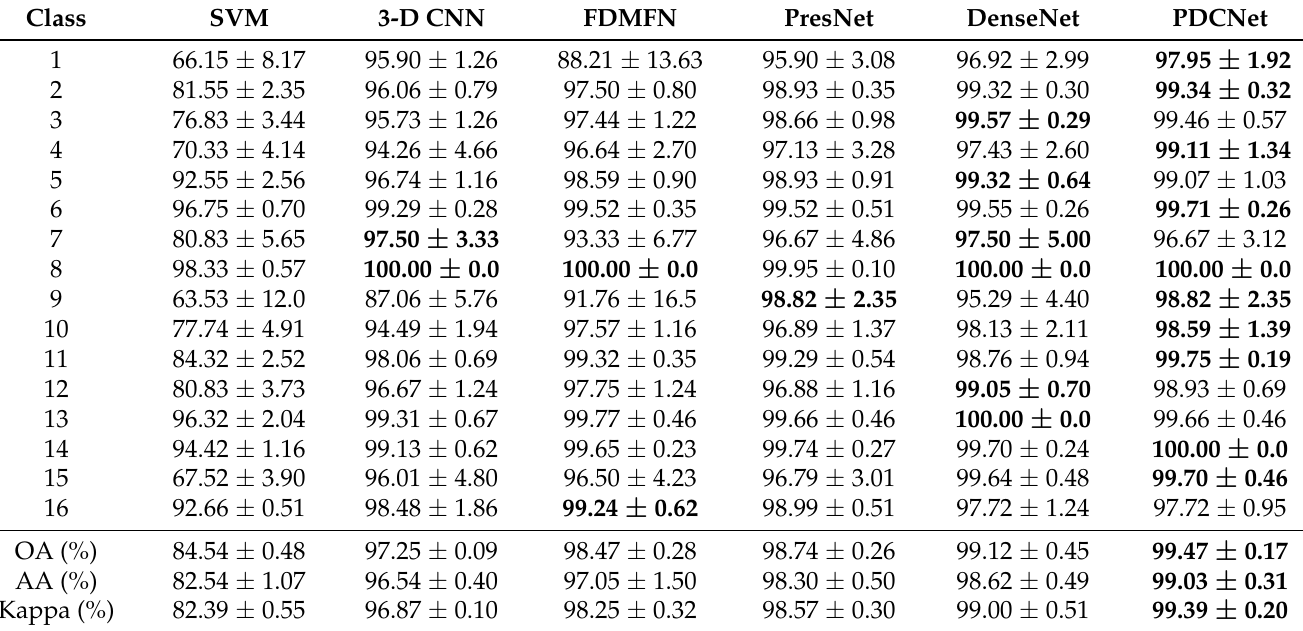
Table 8. The classification results for the IP dataset based on 15% training samples. The best results are highlighted in bold